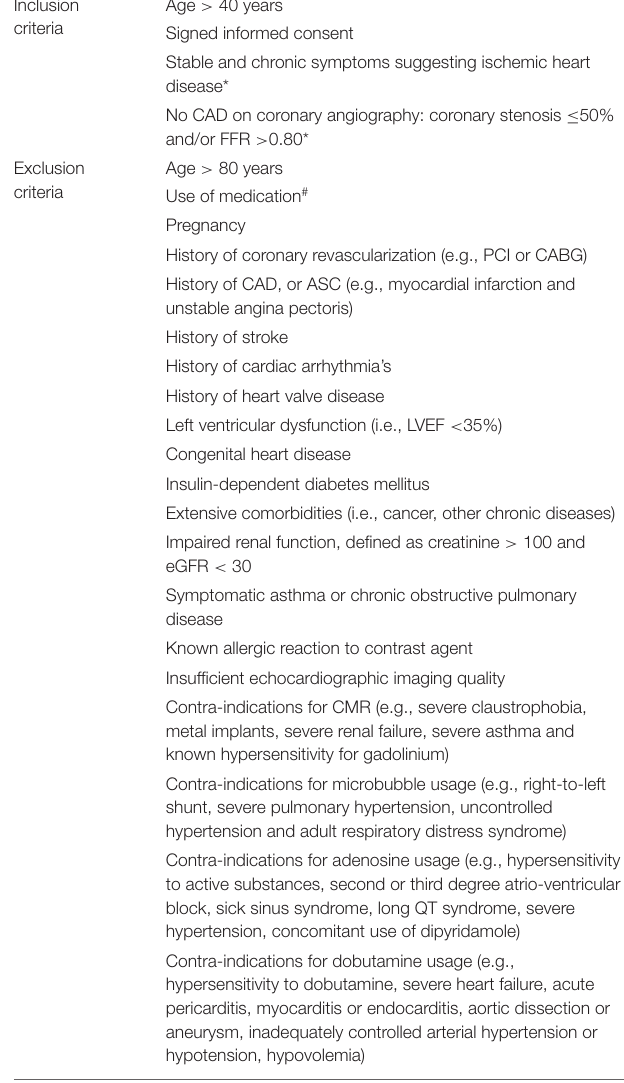
TABLE 3 | Inclusion and exclusion criteria patient and control